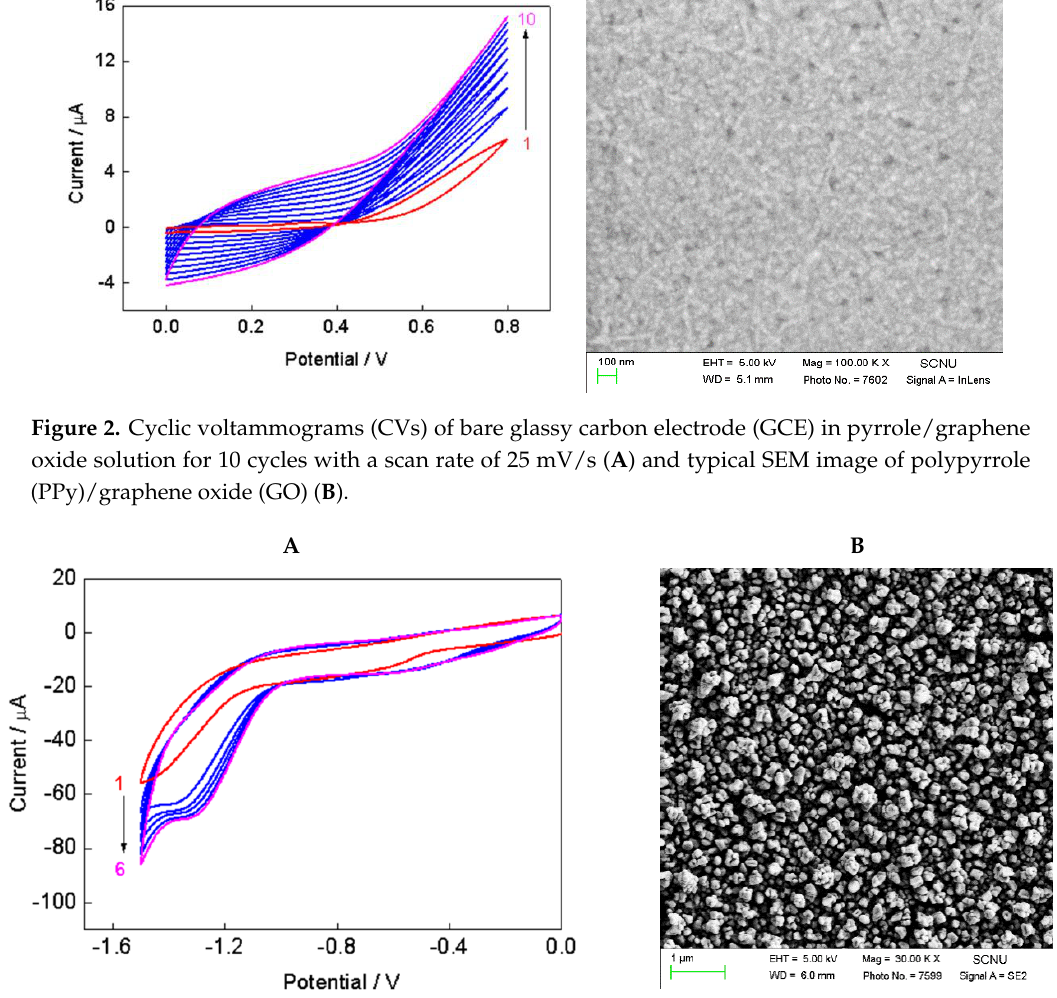
Figure 3. CVs of PPy-GO/GCE electrode in HAuCl 4 aqueous solution for 6 cycles with a scan rate of 25 mV/s ( A ), and the typical SEM image of PPy-RGO-AuNPs ( B ).